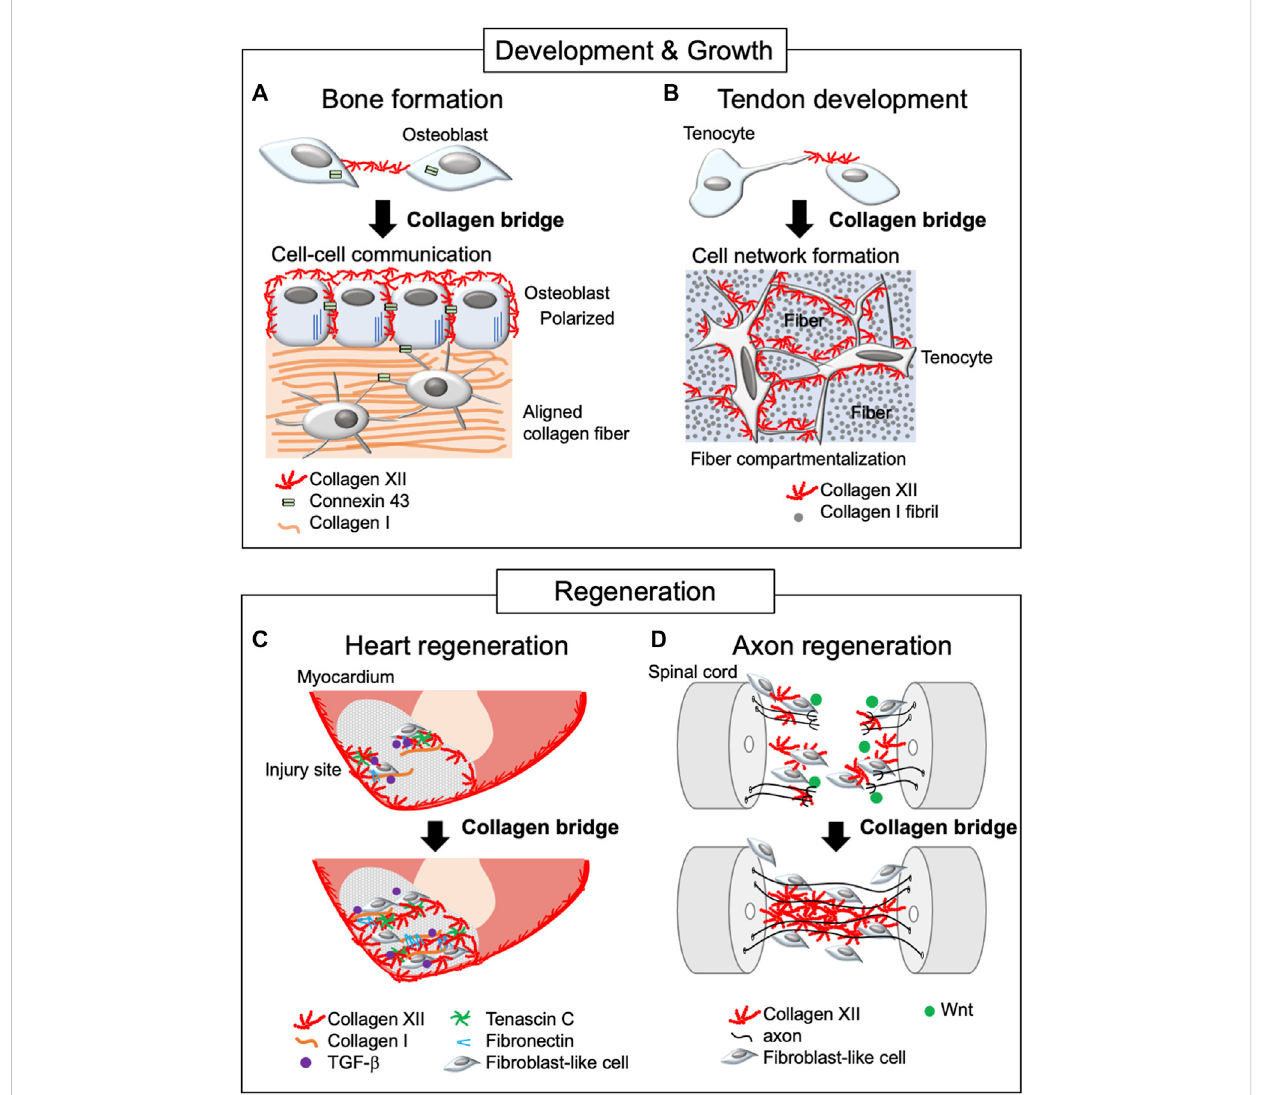
FIGURE 2 Schematic diagram of collagen XII bridge formation during development, growth, and regeneration. The diagram illustrates bone formation (A) , tendon development (B) , and heart (C) and axon regeneration (D) . Collagen XII bridges are formed between adjacent cells during bone formation and tendon development, making intercellular network formation necessary for developing functional tissue. In the regeneration process, collagen XII accumulation is found at the leading edge of the injured sites and bridges between truncated tissues, allowing cell migration. This is under the control of TGF- β and Wnt/ β -catenin signaling in zebra fi sh during heart and axon regeneration,